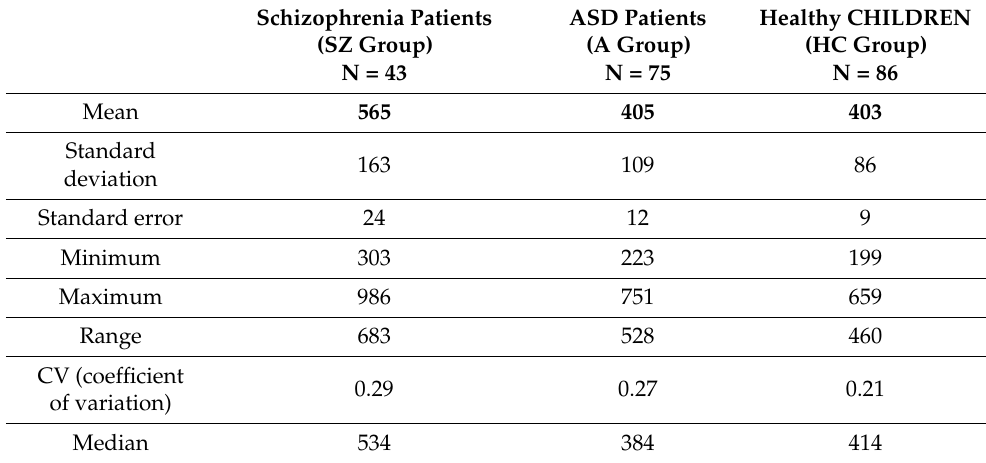
Table 2. Descriptive statistics for the rDNA copy number values in the three groups